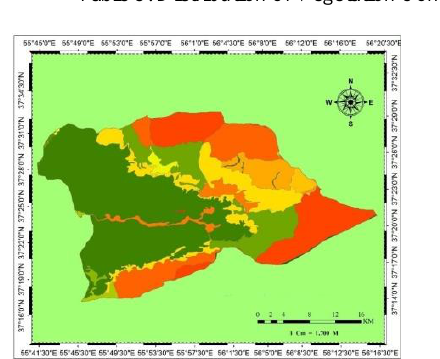
Figure 6. Vegetation map of the study area